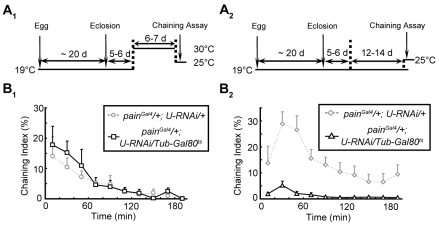
Downregulation of the expression levels of painless exclusively in adulthood resulted in male–male courtship behavior.(A1 and A2) Schematic representations of the experimental design used to manipulate the expression levels of painless. Flies were raised and maintained at different temperatures, as indicated. Average ChI of males of indicated genotypes reared according to the strategies shown in A1 (B1) or A2 (B2). Error bars represent SEM, and n>8 in each trace.